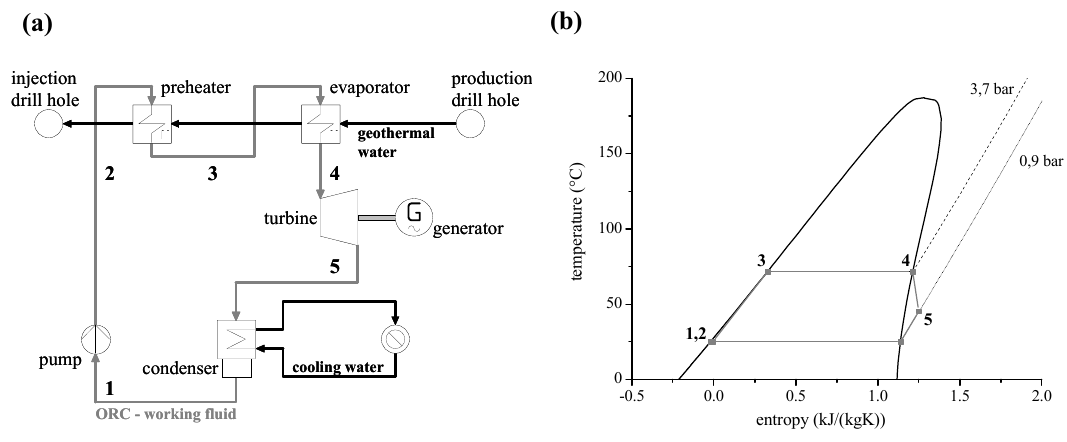
Figure 3. Scheme of ORC-unit ( a ) and corresponding T , s -diagram for ORC with the working fluid isopentane ( b ).